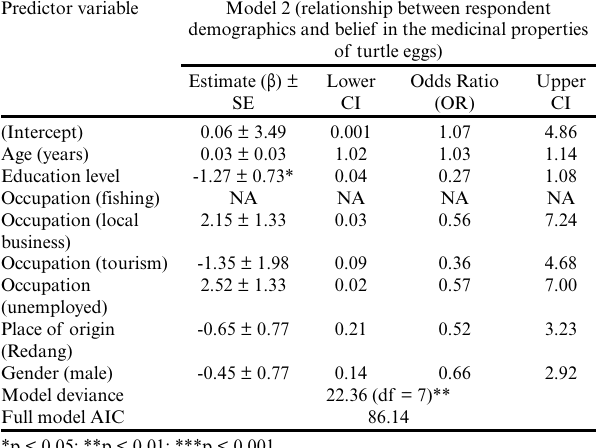
Table 6 . Results of the logistic regression model that explains the influence of respondents’ demographics on the perceived negative effect of the protection status on their livelihood (n = 73). Values indicate the coefficient estimates ( β ) ± standard errors of estimates (SE), model deviance and the associated degrees of freedom (df), and p-value.